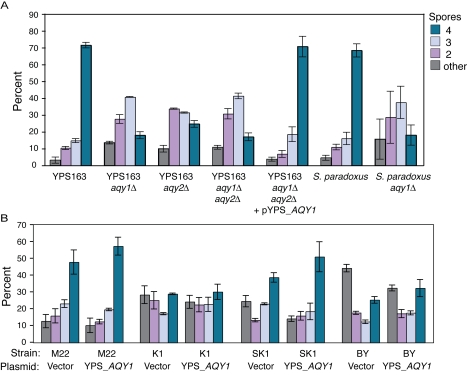
AQY function is required for sporulation in YPS163.(A) Denoted strains were sporulated as described in Methods for 2 days, and the number of events with 4, 3, 2 spores or ‘other’ (representing unsporulated or unscorable cells) was recorded. Each plot represents the average and standard deviation of biological triplicate. Results from S. paradoxus strain NRRL Y-17217 are shown here. (B) Vineyard strain M22, sake strain K1, SK1, and S228c derivative BY4743 (BY) harboring empty vector or pYPS_AQY1 plasmid were sporulated as described for 2–3 d before scoring.